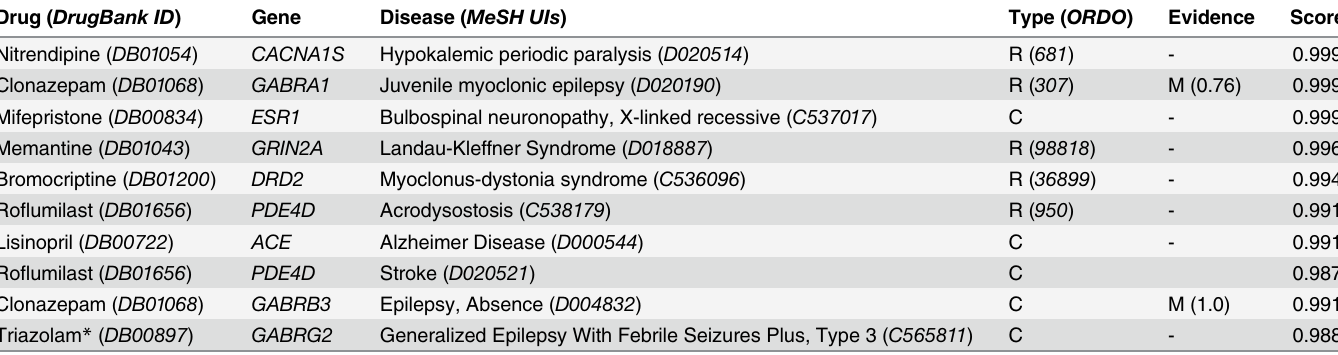
Table 5. Top 10 inferred associations involving unique diseases of the nervous system.